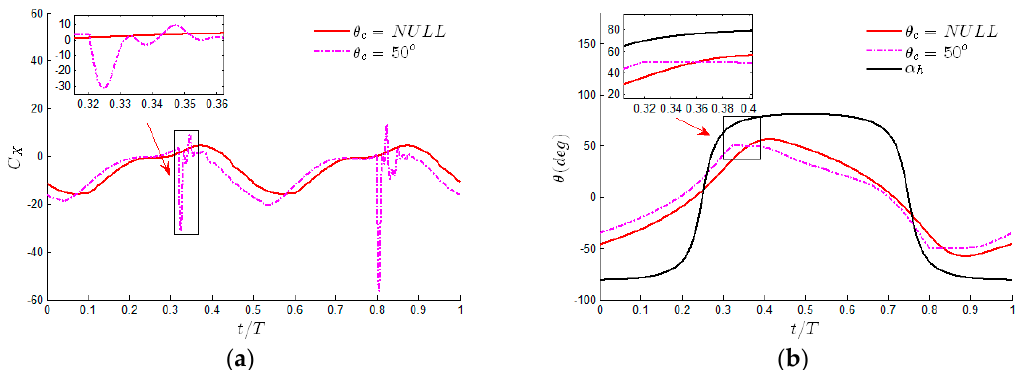
Figure 18. Evolution of (a) the thrust coefficient and (b) the pitching profile at 𝑘 ∗ = 0.09 , 𝑦 (cid:2868) = 0.2 , 𝑓 ∗ = 0.68 .